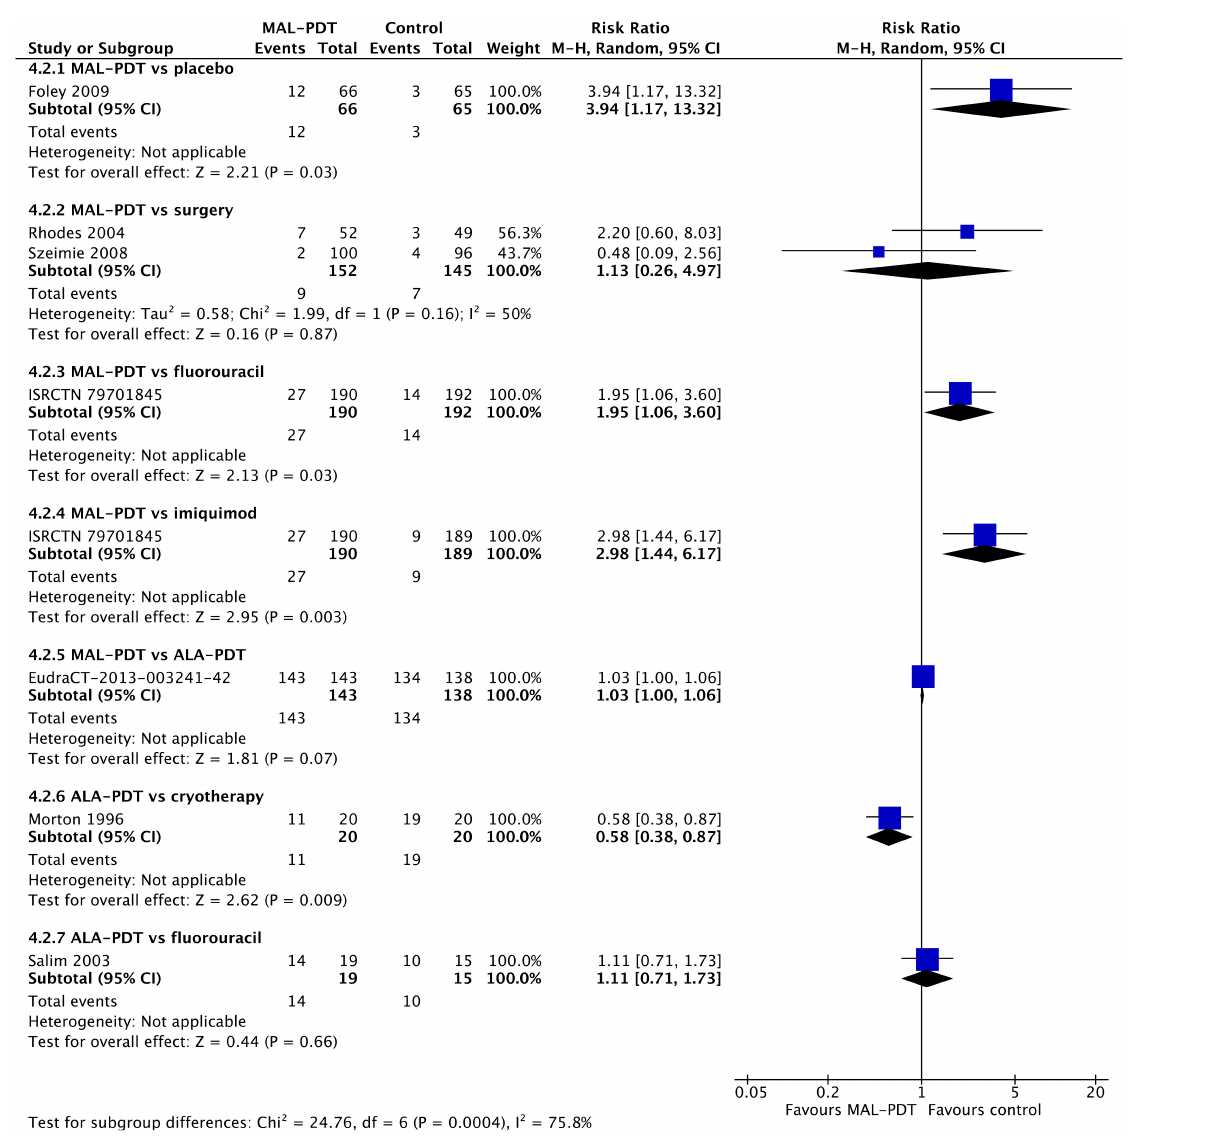
FIGURE8 Meta-analysis of the risk of pain during the procedure by comparator. Data are risk ratios with 95% confidence